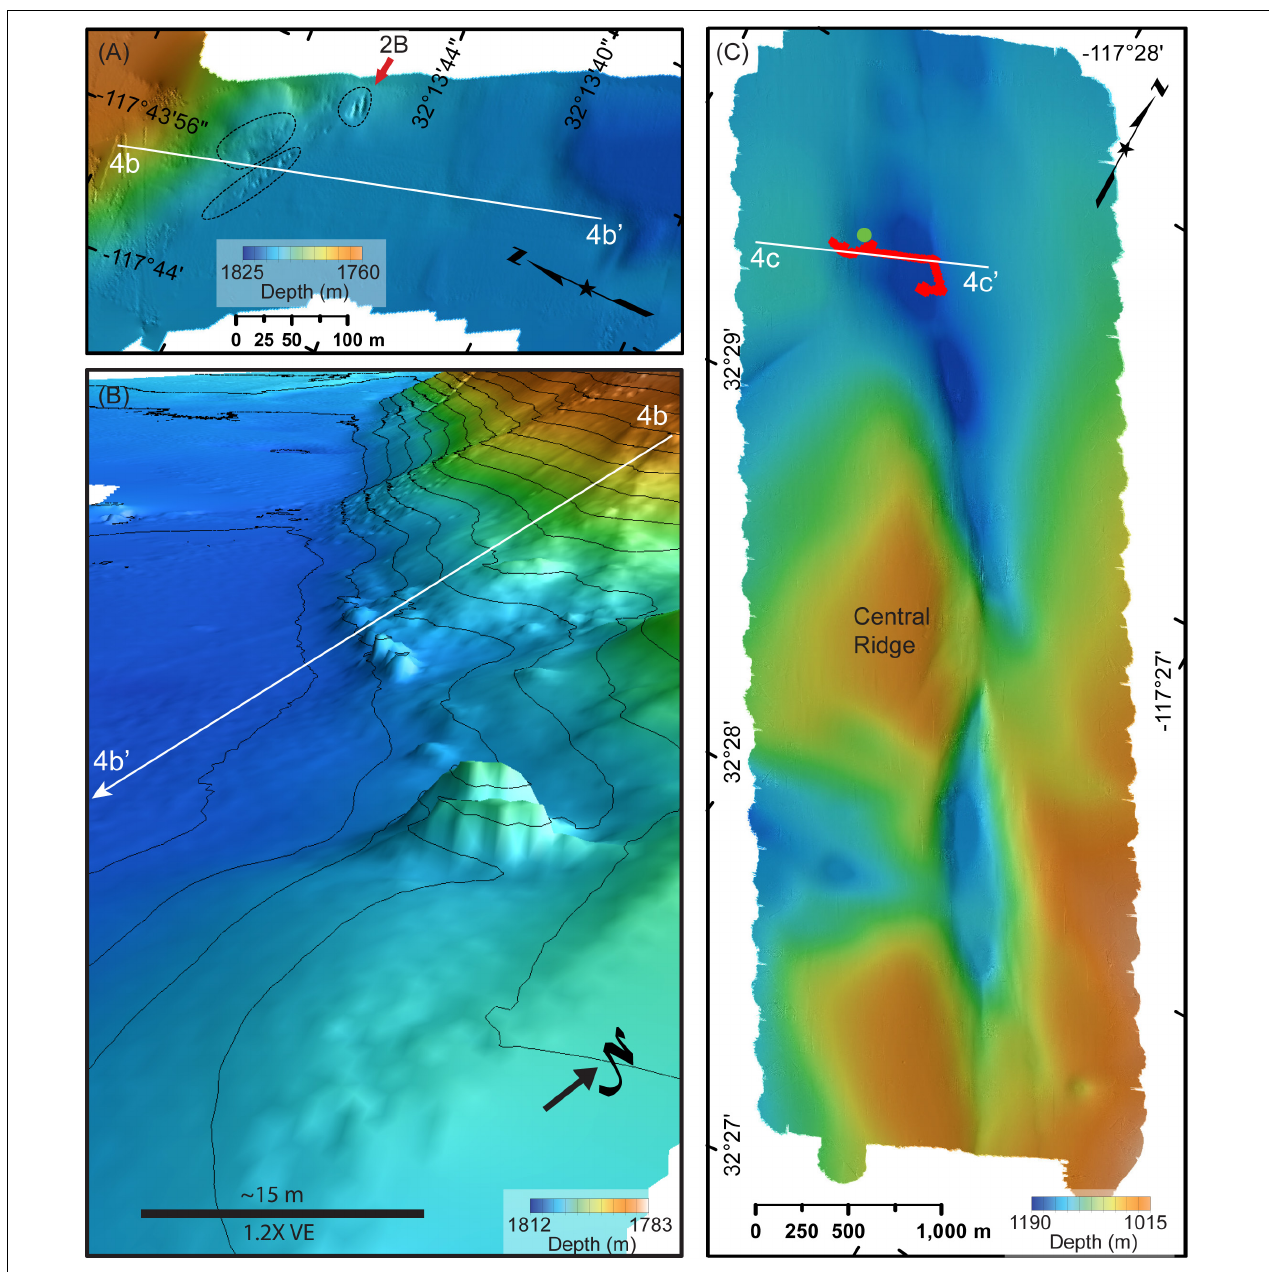
FIGURE 2 | (A) A small section of AUV collected bathymetry on the San Clemente Fault in the Navy Fan area. Black dashed lines encircle areas with rough morphology indicative of barite mounds. Red arrow indicates the direction of the perspective view shown in panel B . White line is the location of the chirp sub-bottom profile shown in Figure 4B . (B) A perspective view of the mounds on the escarpment above the San Clemente Fault. Contours are 2 m. White line is the location of the chirp sub-bottom profile shown in Figure 4B . (C) AUV collected bathymetry on a section of the San Diego Trough Fault. The red line shows the path of ROV dive DR769. The green dot indicates the location of a barite deposit. White line is the location of the chirp sub-bottom profile shown in Figure 4C